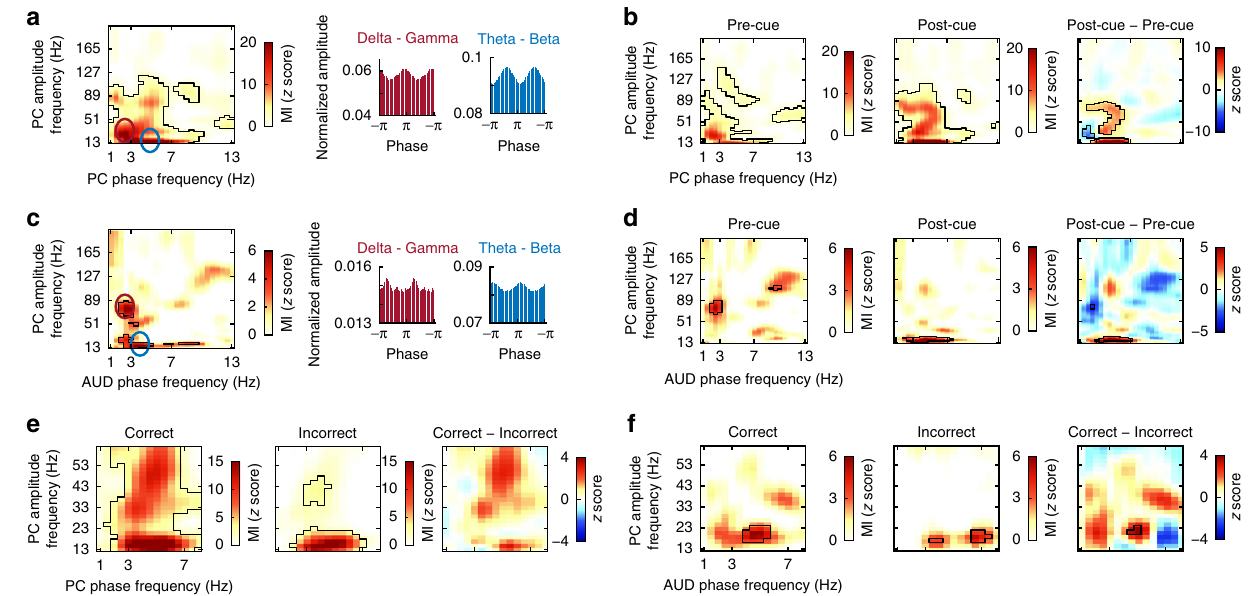
Fig. 5 Auditory cues induced cross-frequency coupling. a On the left, group-level comodulograms of within-piriform cortex (PC) cross-frequency coupling are shown. Values on the plot represent the modulation index (MI) for each phase amplitude pair (see Methods). On the right, phase – amplitude distributions of the maximal modulatory frequency are shown (corresponding to red and blue circles on the left panel). b Auditory cue-induced changes in phase – amplitude coupling in PC. In the left and middle columns, comodulograms computed from pre-cue ([ − 5, 0] s) and post-cue ([0, 5] s) time windows are shown separately, with the difference between the two on the far right. c On the left, group-level comodulograms of between auditory (AUD) – piriform cross-frequency coupling are shown. Values on the plot represent the MI for each phase amplitude pair (see Methods). On the right, phase – amplitude distributions of the maximal modulatory frequency are shown (corresponding to red and blue circles on the left panel). d Auditory cue-induced changes in phase – amplitude coupling between AUD and PC. In the left and middle columns, comodulograms computed from pre-cue ([ − 5, 0] s) and post-cue ([0, 5] s) time windows are shown separately, with the difference between the two on the far right. e , f Phase-amplitude coupling between AUD and PC amplitude is stronger during correct trials. Comodulograms computed separately for correct and incorrect trials for both within-PC coupling (left) and AUD – PC coupling (right) are shown. Increased modulation during correct compared to incorrect trials was only evident for AUD – PC coupling in the theta – beta ranges. In all instances, comodulogram z scores were corrected for multiple comparisons using false discovery rate ( p < 0.05, permutation